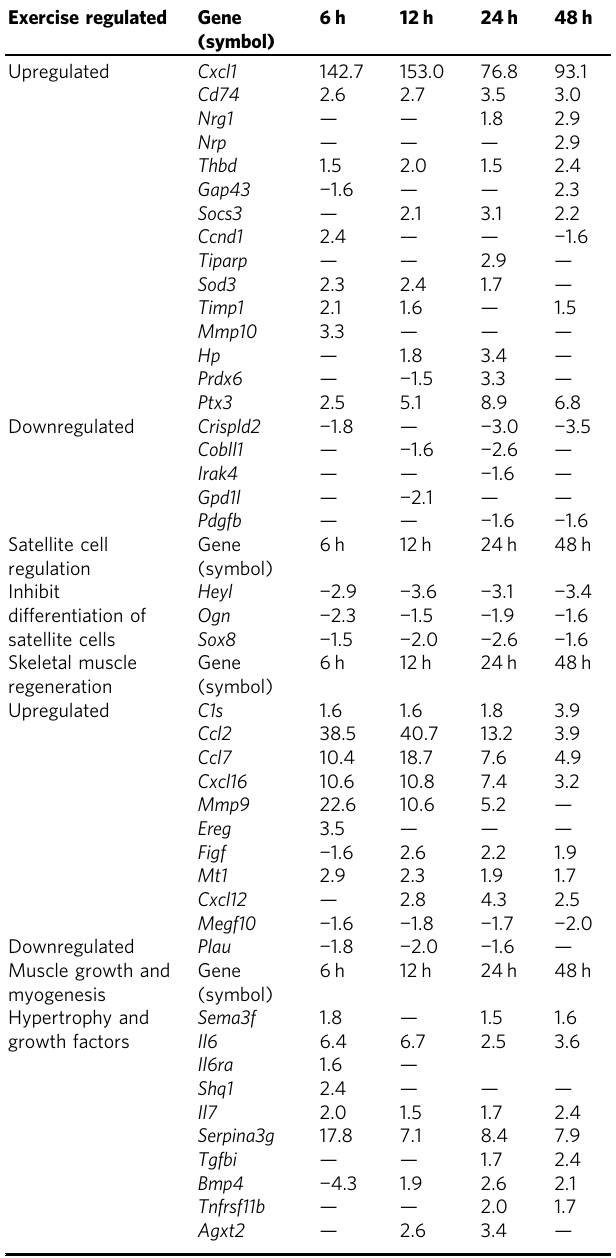
Table listing differentially expressed genes, identi fi ed through microarray analysis, between myotubes treated with either DB (control) or irisin for 6, 12, 24, and 48h. Genes have been manually separated into exercise regulated, satellite cell regulation, skeletal muscle regeneration,andmuscle growth andmyogenesiscategories.Gene symbolsandfold changesat each treatment time point are given. Negative numbers re fl ect fold repression of gene expression. Only genes that were upregulated or downregulated by ≥ 1.5-fold were